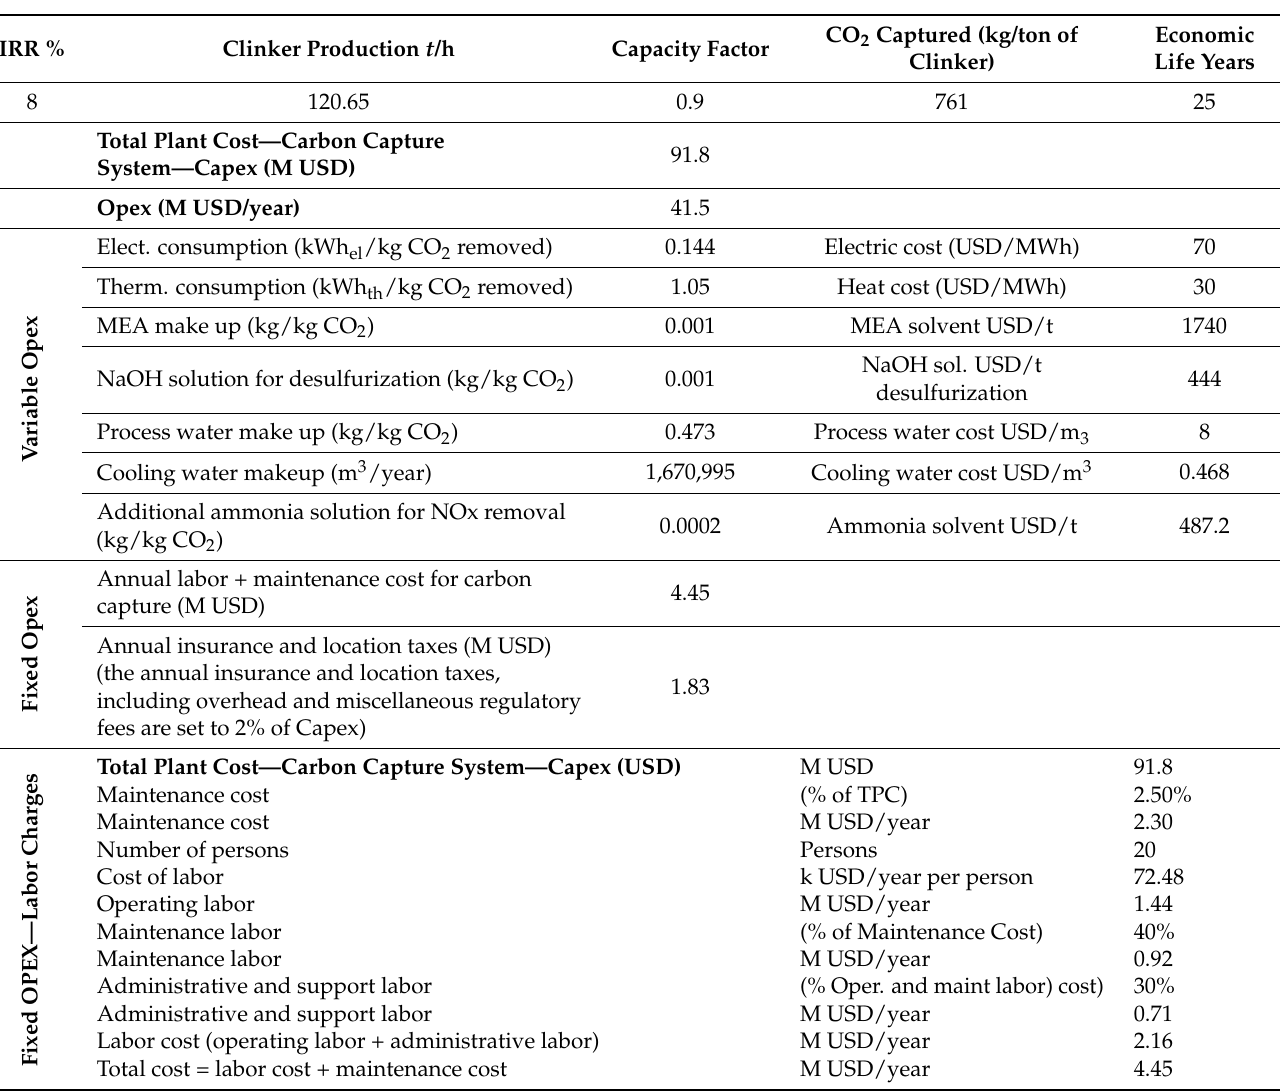
Table 2. Cost inputs for CO 2 capture from cement plant from